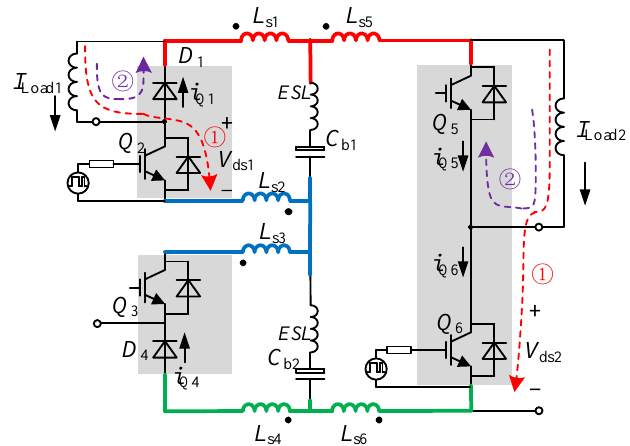
Figure 17. Dynamic pulse test circuit. Table 2. Key parameters of the dynamic pulse test circuit.